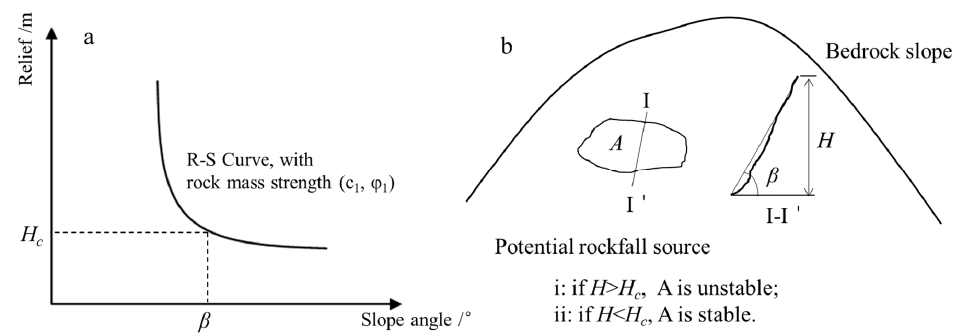
Figure 3. Sketch map describing the approach. ( a ) Slope angle versus relief for hillslope. ( b ) Sketch map of estimating the state of stability for the specific area (A).